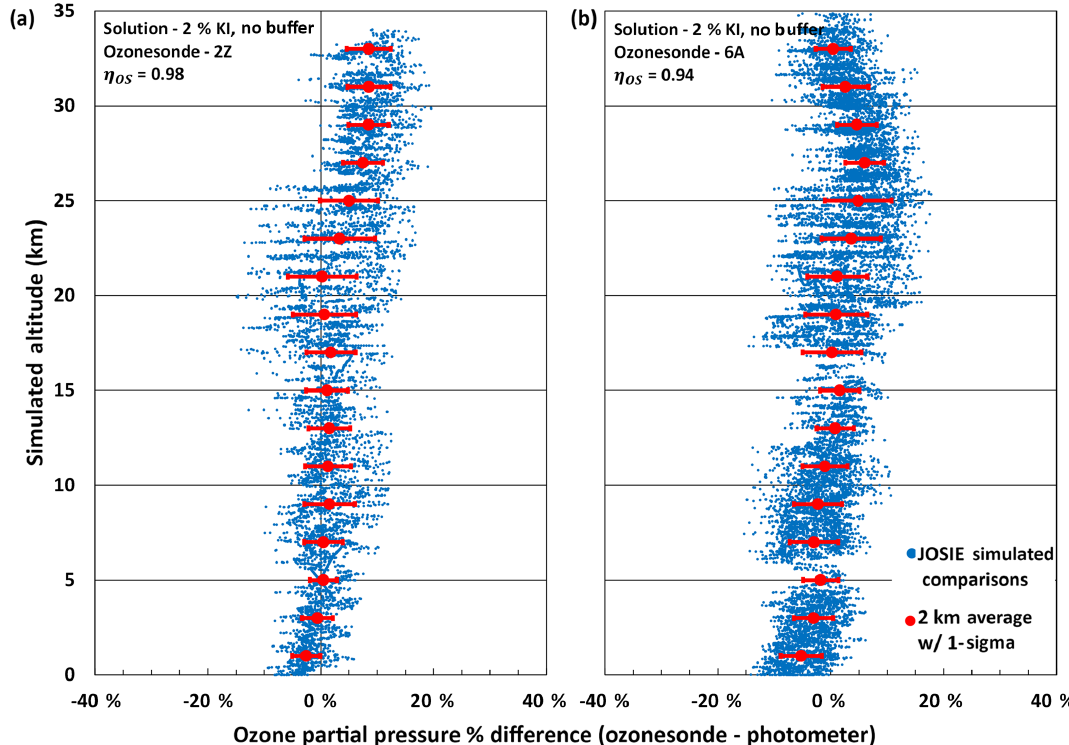
Figure 5. Percent difference in ozone partial pressure between the ozonesonde and the reference ozone photometer with 2% no buffer solution and 2Z EN-SCI (a) and 6A Science Pump (b) ozonesondes after applying the ozone sensor